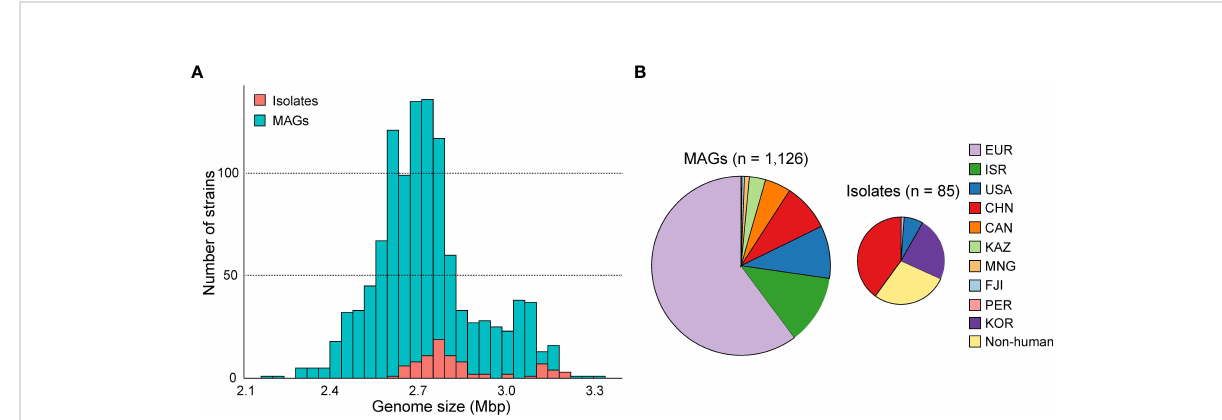
FIGURE 1 The genome size and country distribution of 1,211 strains of Akkermansia . (A) Distribution of genome size of 1,126 metagenome-assembled genomes (MAGs) and 85 isolated genomes. (B) Country distribution of 1,126 MAGs and 85 MAG isolated